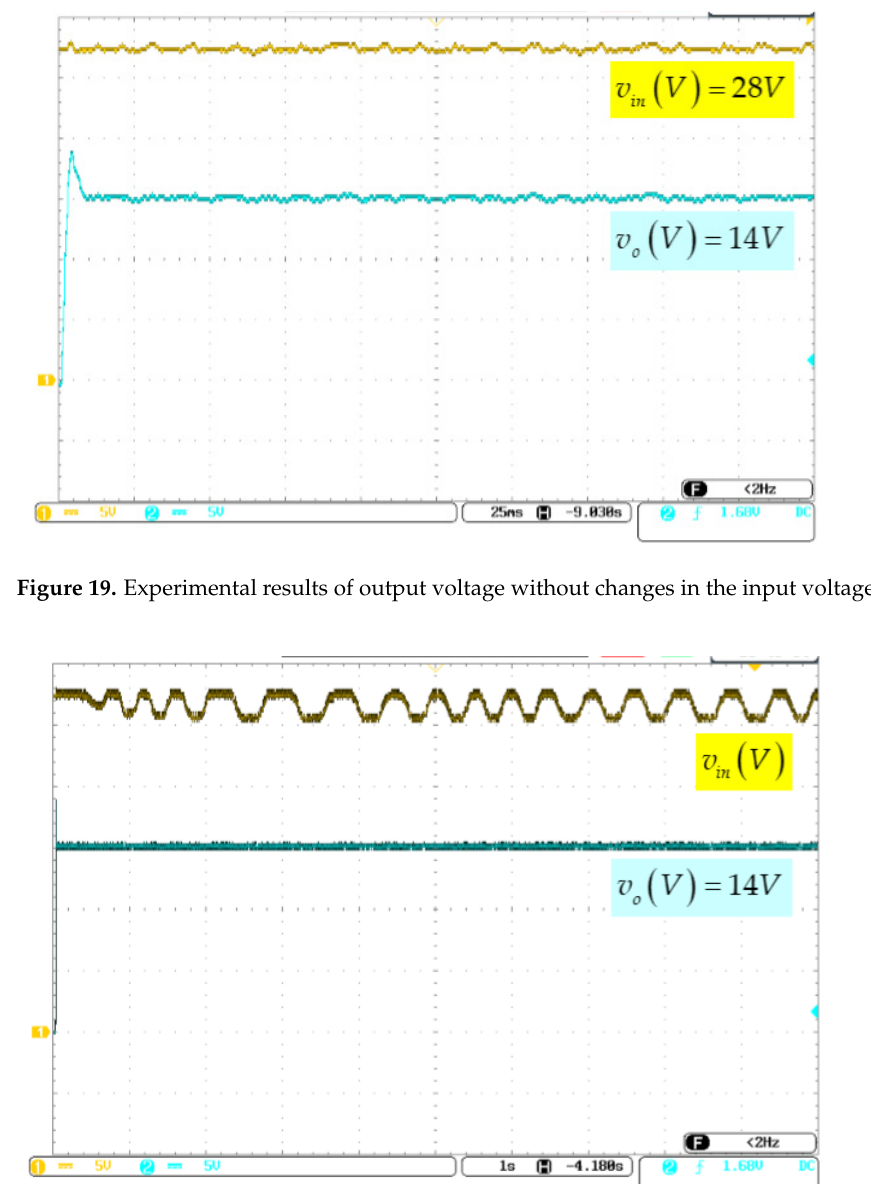
Figure 20. Experimental results of output voltage under the input voltage variation test.